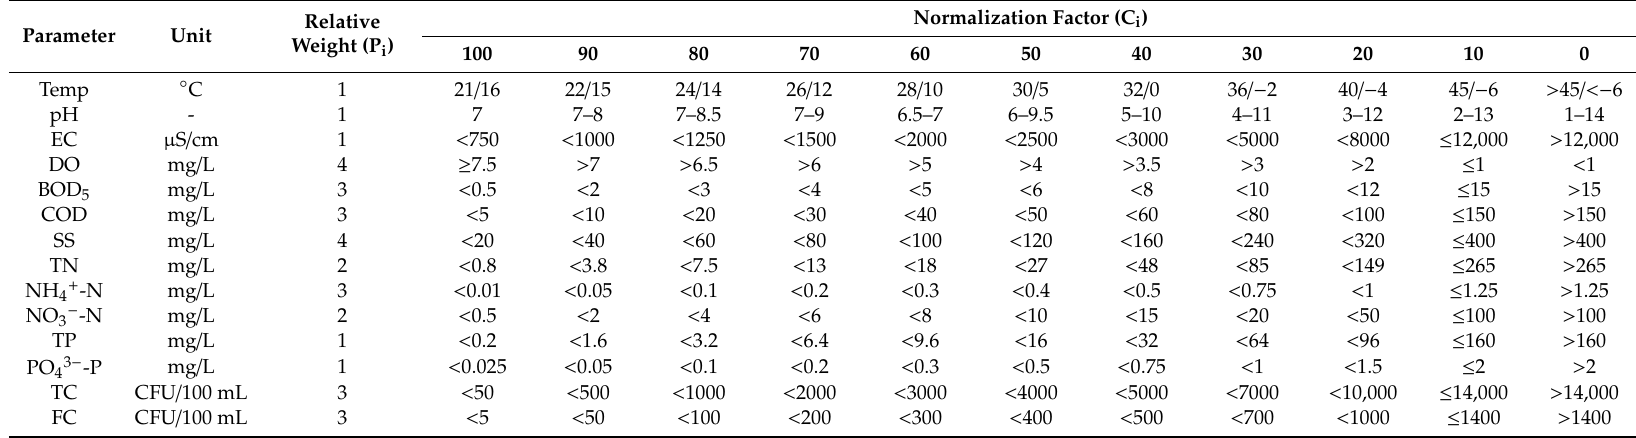
Table 1. Reference values (i.e., normalization factors, C i and weights, P i ) required to develop the Bascar ó n WQI and provided by previous studies